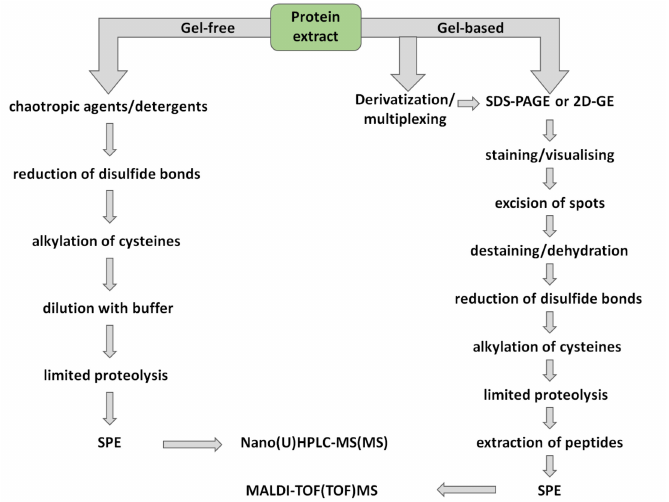
Figure 2. Overview of enzymatic digestion implemented in gel-based and gel-free experimental